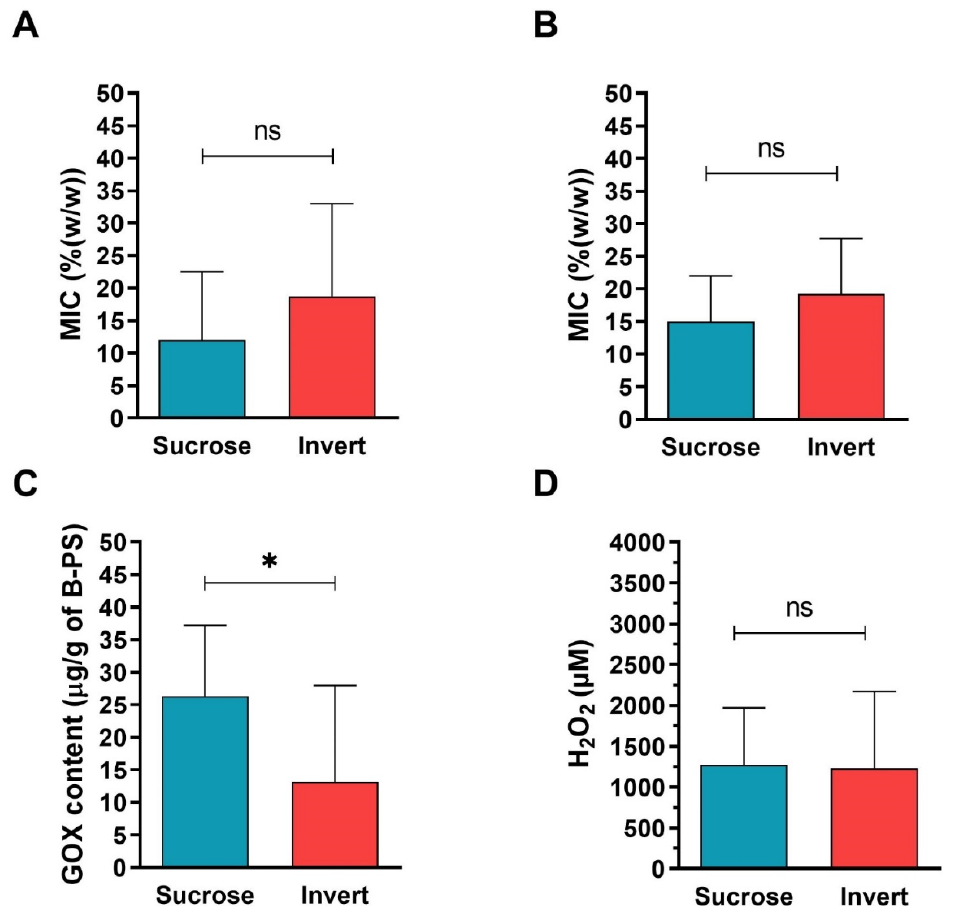
Figure 5. Antibacterial activity of bee-processed syrups (B-PS) and GOX contents and H 2 O 2 levels in B-PS collected after processing sucrose ( n = 11) or invert sugar ( n = 8) feeds in the bee colony. Average antibacterial activities of B-PS against Staphylococcus aureus ( A ) and Pseudomonas aeruginosa ( B ). Average GOX contents ( C ) and levels of H 2 O 2 ( D ) in BP-S. Data are expressed as the mean values with SD. * p < 0.05 (unpaired t -test).